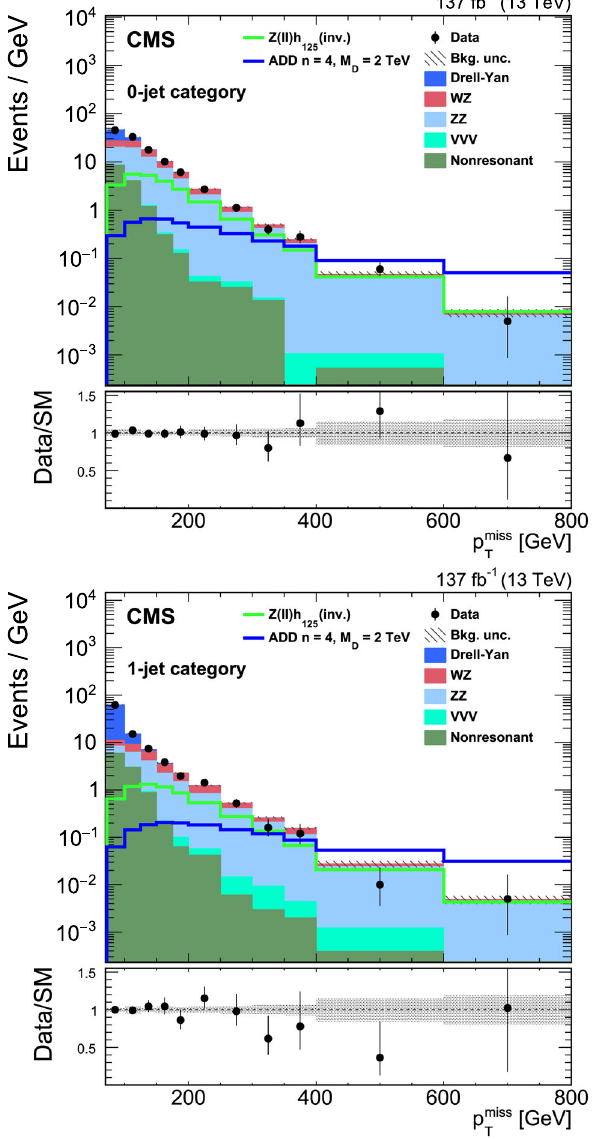
Fig. 3 The p miss distributions for events in the signal region in the 0- T jet (upper) and 1-jet (lower) categories. The rightmost bin also includes > 800GeV. The uncertainty band includes both events with p miss T statistical and systematic components. The Zh ( invisible ) signal nor- malization assumes SM production rates and the branching fraction B ( h → invisible ) = 1. For the ADD model, the signal normalization assumes the expected values for n = 4 and M D = 2TeV